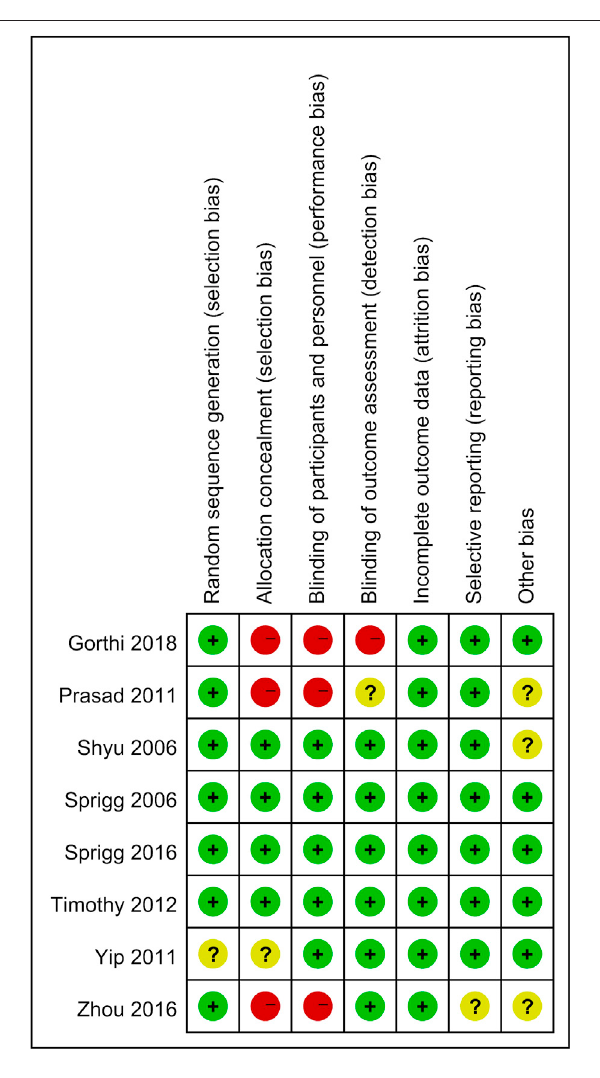
FIGURE 3 | Risk of bias